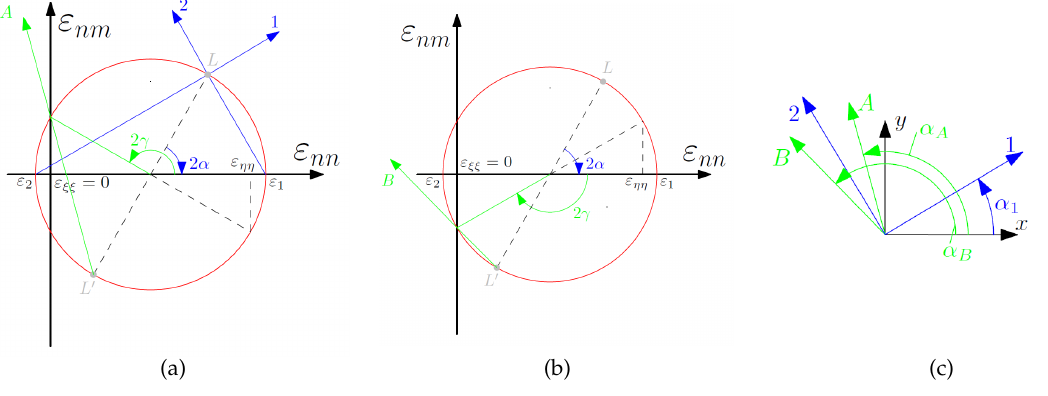
Figure 1. ( a,b ) Mohr’s circle for plane strain with zero-strain directions A and B; and ( c ) principal strain directions and zero-strain directions illustrated at the considered strain location